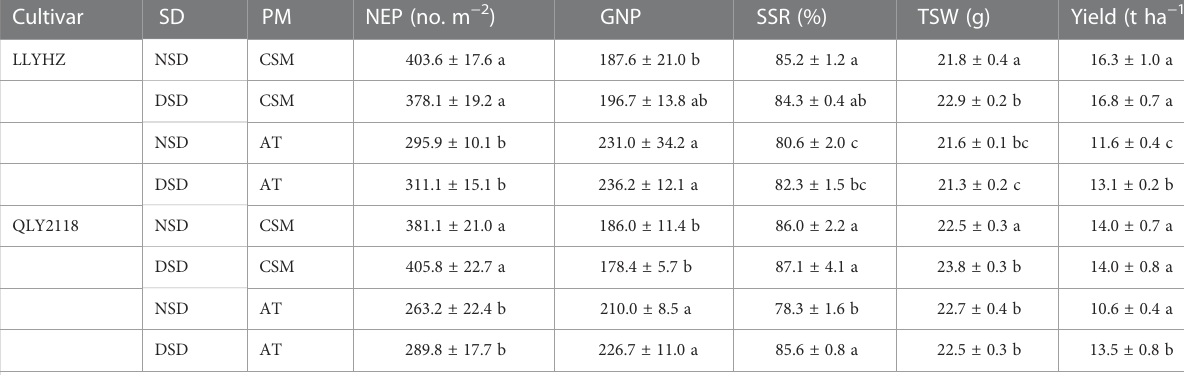
TABLE 2 Yield of two rice cultivars in the different treatments and their yield components. Cultivar